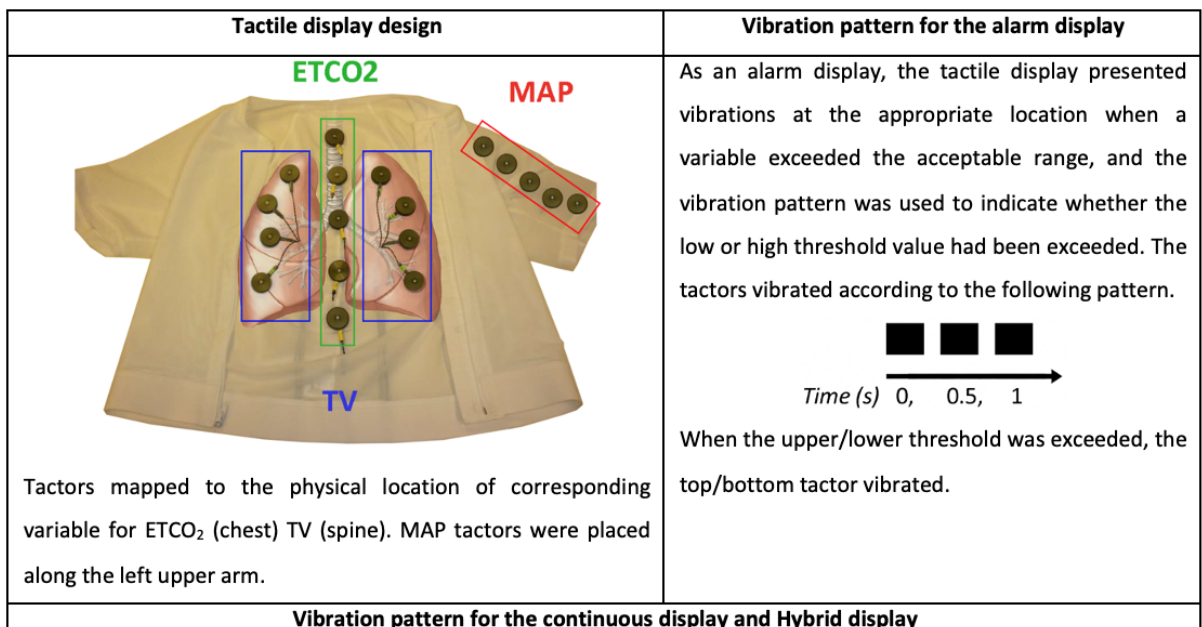
Figure 10. Tactile display by Ferris and Sarter [22]. The vest could be configured in 3 different modes: alarm, continuous, and hybrid display (image created based on the concepts presented in the paper and Ferris’PhD